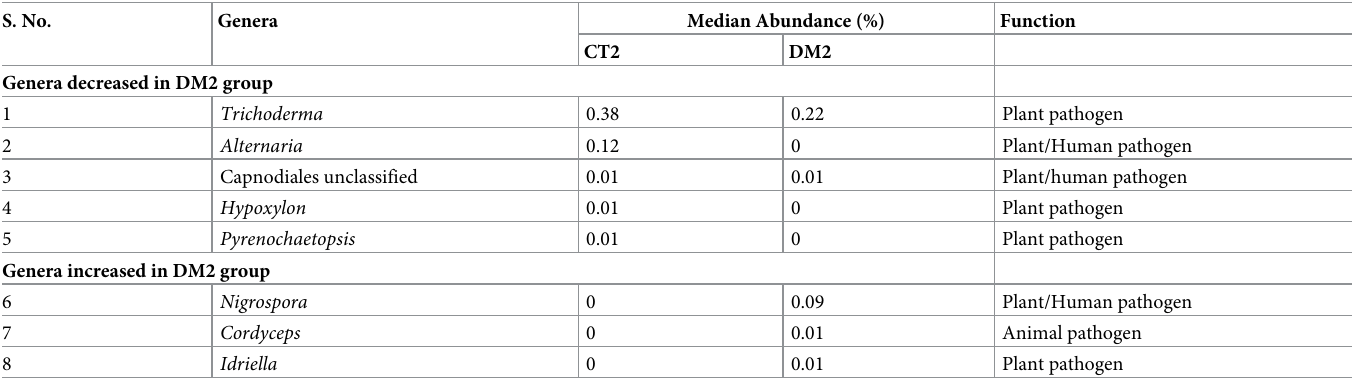
Table 4. Significant differences in the median abundance of discriminatory genera ( > 0.01% in any one of the groups; P-value � 0.05) in gut mycobiomes from con- trol (CT2, n = 6) and diabetic (DM2, n = 6) rats. S.